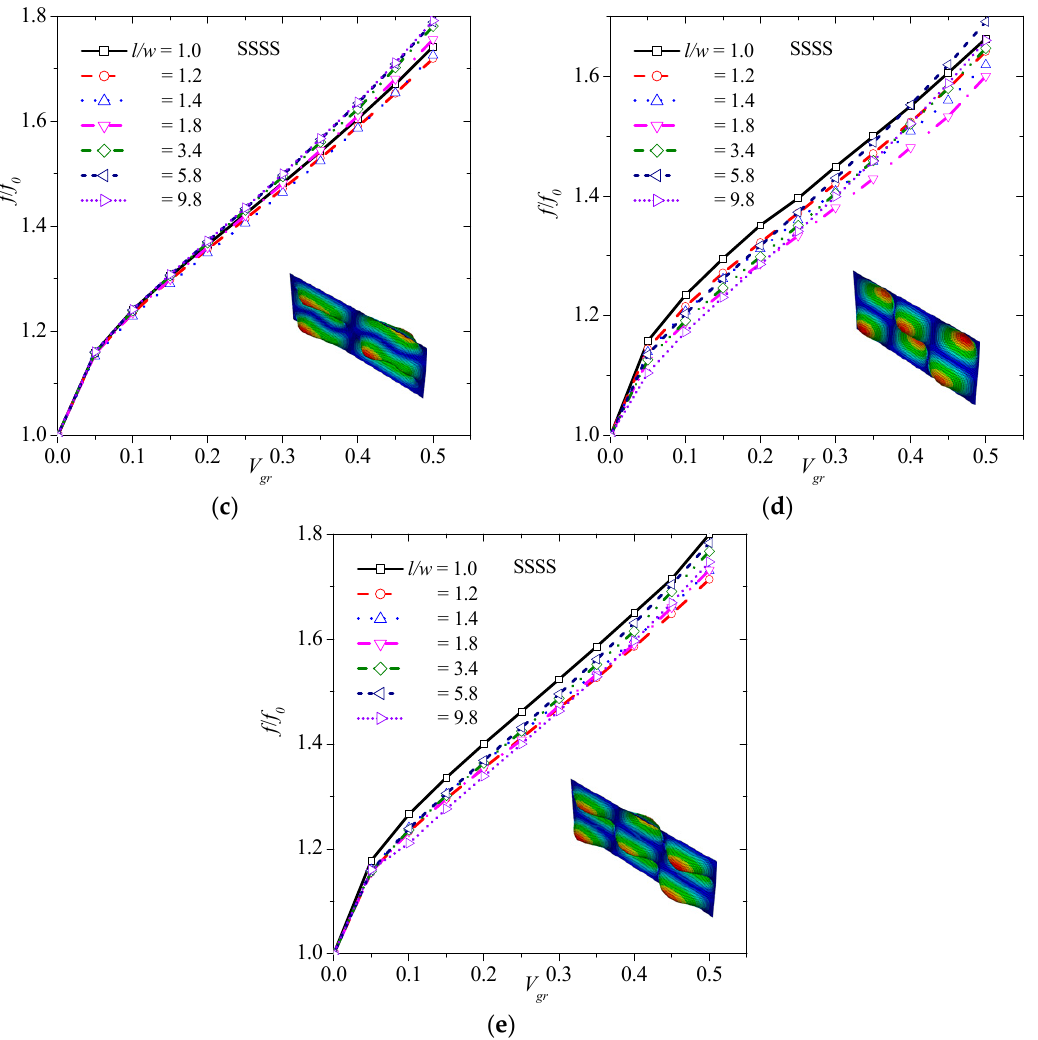
Figure 7. Normalized frequency versus volume fraction of graphene considering ( a ) (1,3), ( b ) (3,1), ( c ) (2,3), ( d ) (3,2), and ( e ) (3,3) vibration mode for the SSSS boundary condition.